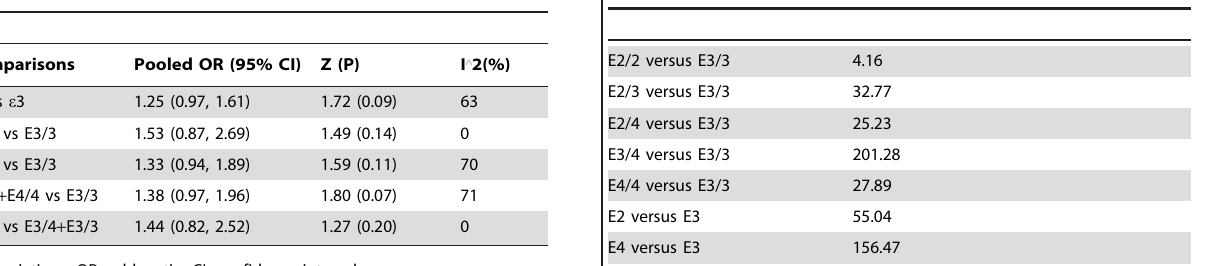
Table 2. Comparisons of E4 vs E3 in allele, genotype dominant and recessive models for GSD risk. Table 3. Fail-safe